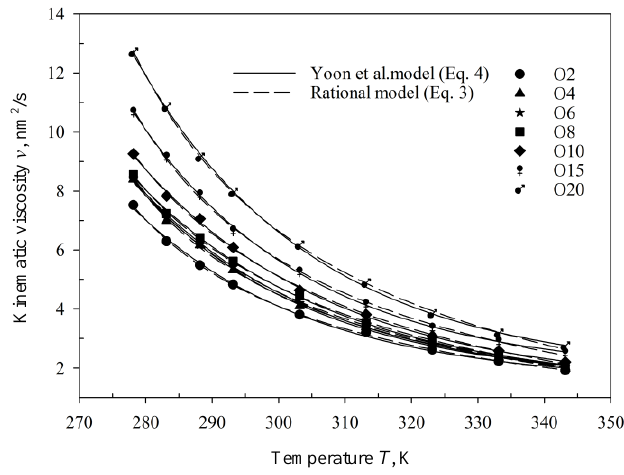
Fig. 1. Changes of kinematic viscosities of O2–O20 with respect to temperature. The validity of the rational and Yoon et al. models for predicting viscosity was also investigated using data of PO-DF binary blends (PO5, PO10, PO15 and PO20) measured by Baroutian et al. [35] at various temperatures (20–90 °C), as shown in Fig. 2. Baroutian et al. [35] prepared their binary blends on volume basis. The viscosity variation of PO-DF binary blends with temperature shows also non-linear behavior. The relation between viscosity and temperature is found to be well expressed by the rational and Vogel et al. models for all studied temperatures. The dynamic viscosity data of PO-DF binary blends measured by Baroutian et al. [35], percent relative errors and regression parameters of models are given in Annex Table 3. The maximum relative errors between the measured and calculated values from Eq. (3) and Eq. (4) were obtained as 3.2725 % and 3.5801 % while the minimum R values were obtained as 0.9994 and 0.9992, respectively, showing that the rational model also better matches to the experimental data given by Baroutian et al. [35].